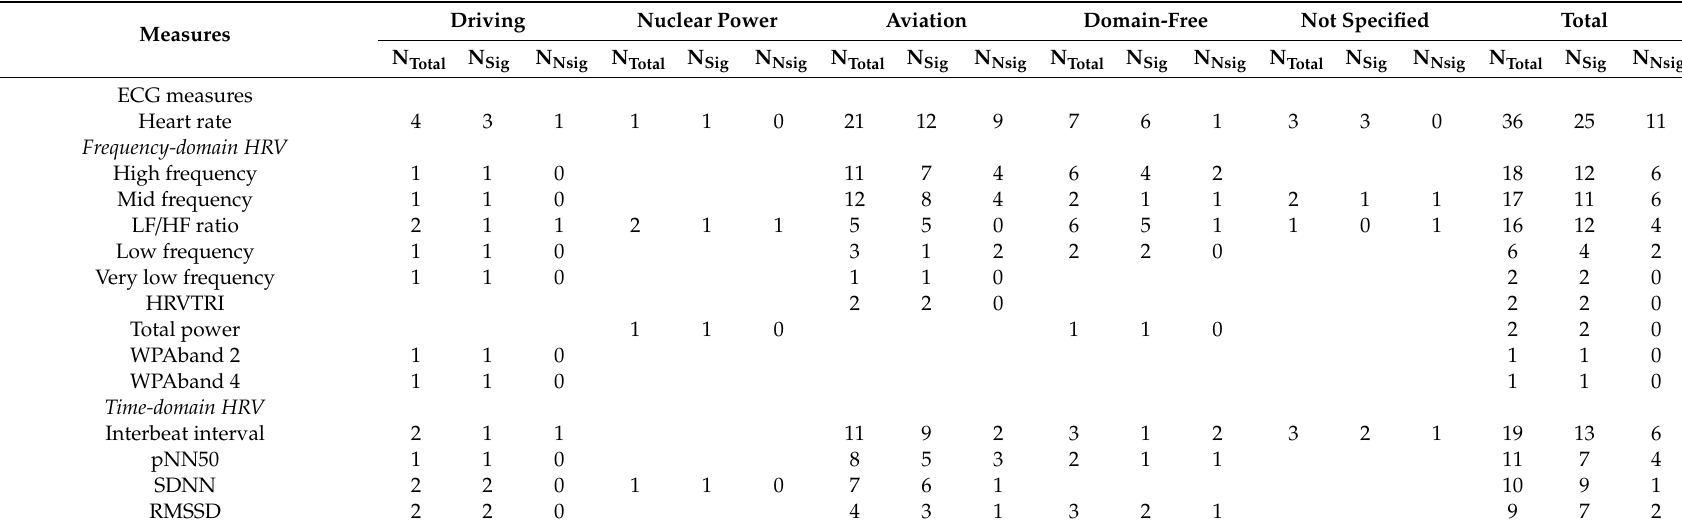
Table 4. Summary of cardiovascular measures and their statistical significance reported in the reviewed